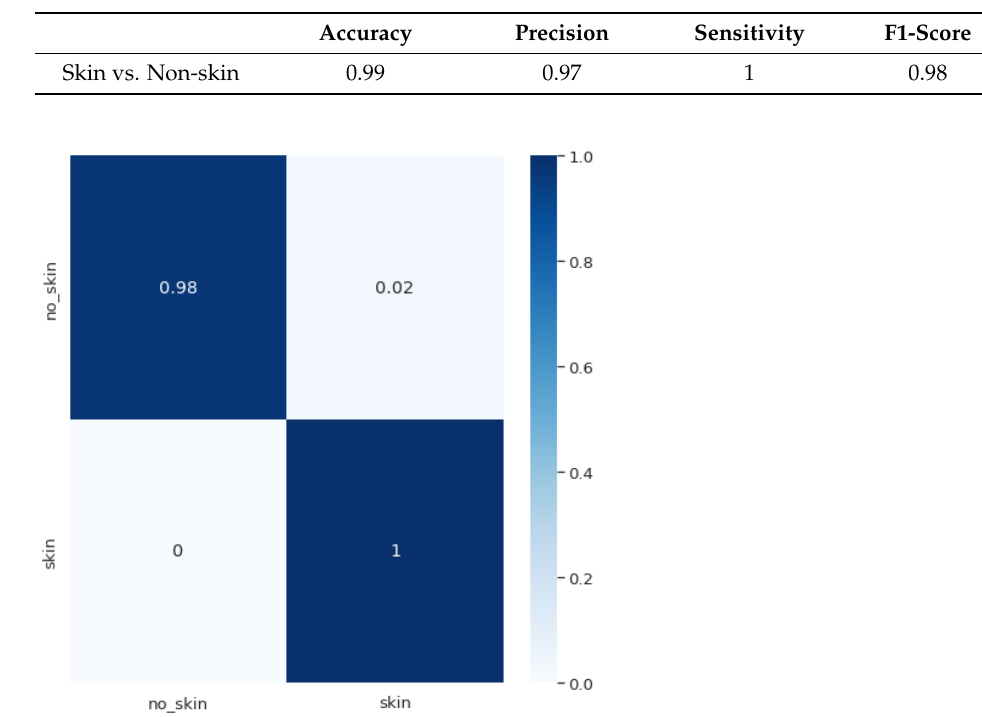
Table 15. Evaluation metrics for the skin classification.